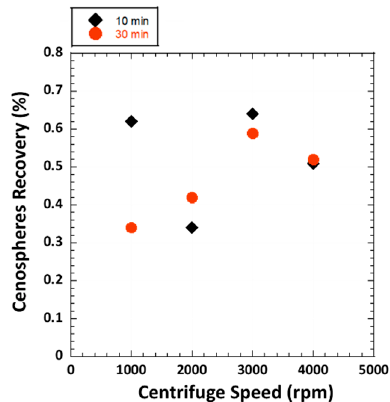
Figure 1. Average percentages of cenospheres recovery yield plotted against centrifugal speed, as the centrifugal time fixed at 10 and 30 min. The SD of each all points is less than 0.01.